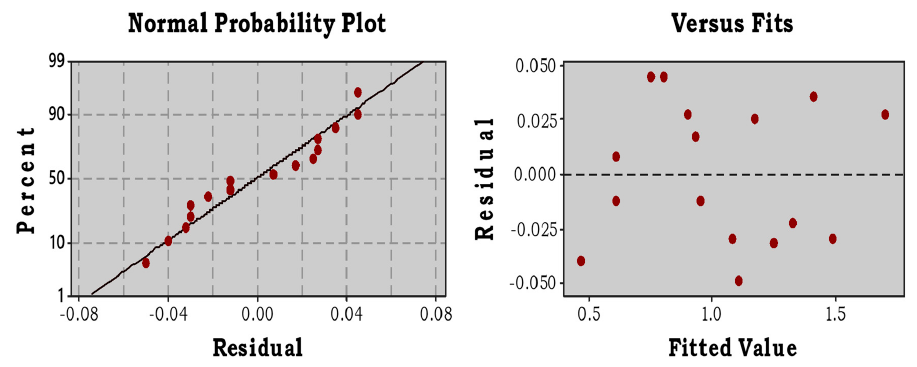
Figure 4. Normal probability plot and residual plots for the Ra value.